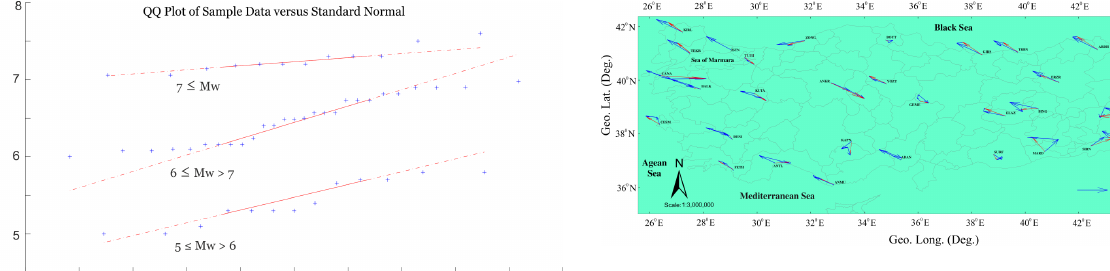
Figure 8: The cumulative (red arrows) and epoch to epoch (blue arrows) displacements over the interval 2009 t0 2017 for TPGN sites relative to the EUREF for coseismic strain due to the earthquakes and epoch network